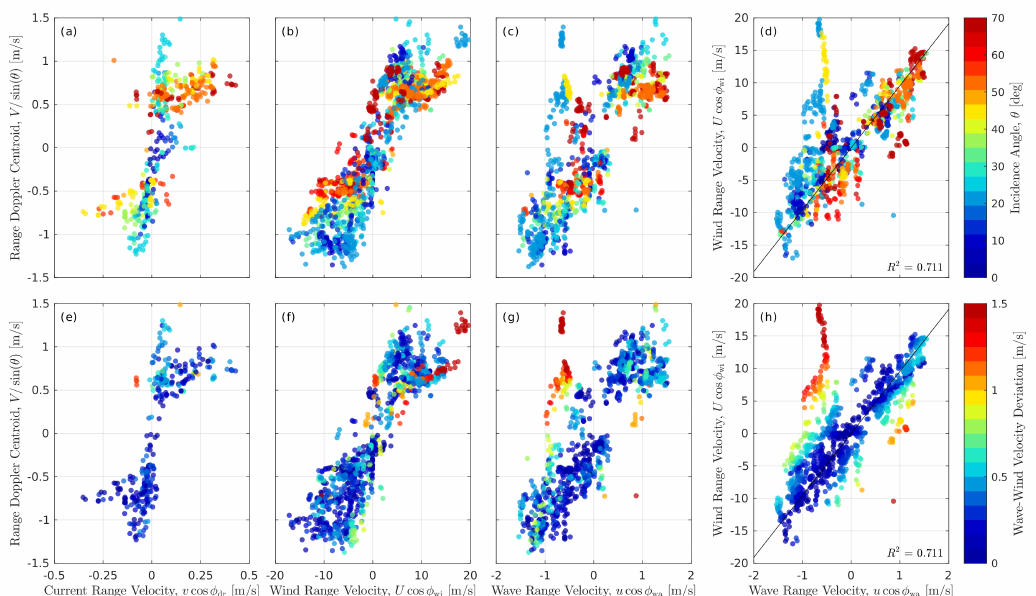
Figure 5. Scatter diagrams of Doppler centroids versus range projection of ( a , e ) sea surface current, ( b , f ) wind velocity, and ( c , g ) wave velocity for VV polarization. The two right plots show scatter diagrams of wind and wave range velocities. Color scale in the top row corresponds to the incidence angle. Color scale in the bottom row corresponds to the deviation of wave range velocity from its average linear wind dependence (black line), i.e., the x-axis distance between a point and the black line in ( d , h ). R 2 is the squared correlation coefficient. All conditions including non-aligned winds and waves are